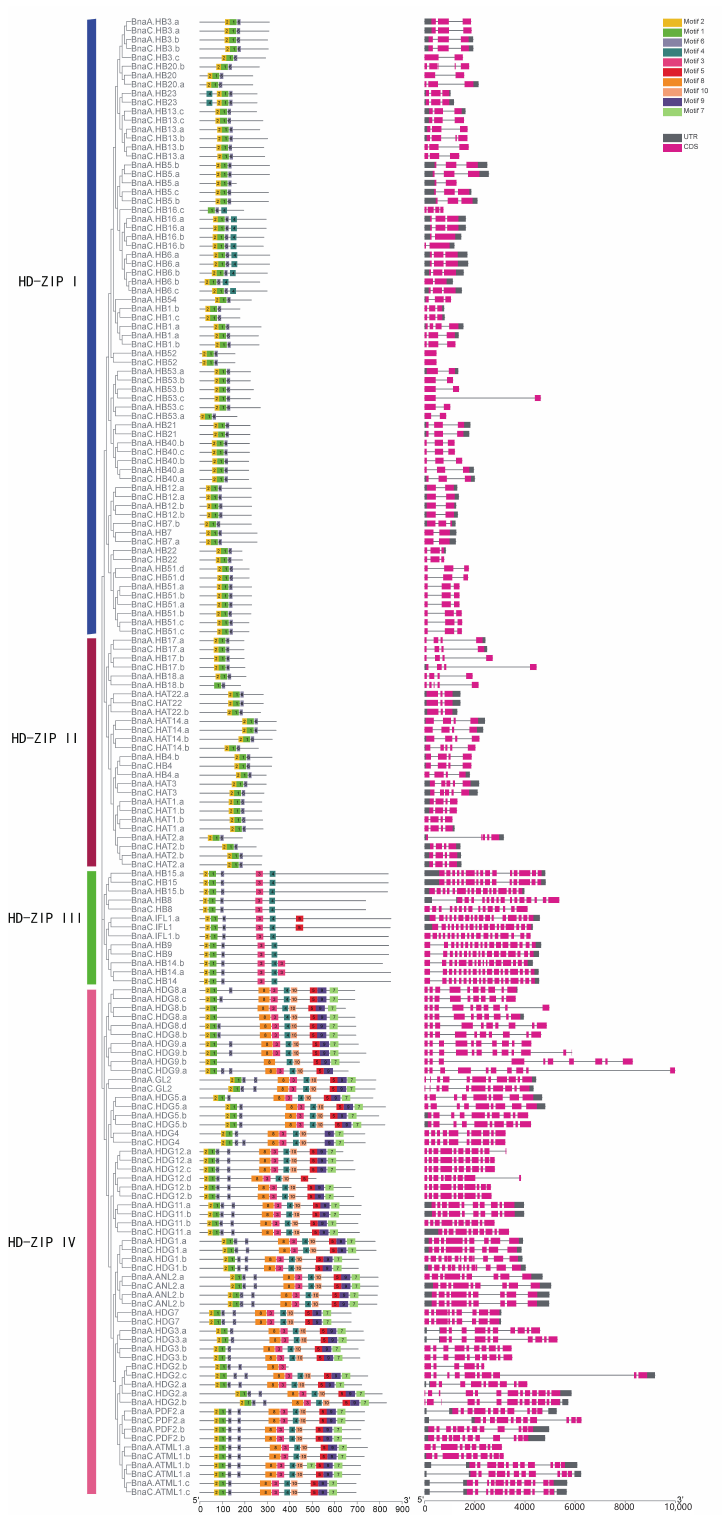
Figure 2. Phylogenetic tree ( Left ), motif distributions ( Medium ), and gene structures ( Right ) of the HD-Zip family in B. napus. The gene structures and motifs had a similar distribution in the same subfamily, and were more complex in subfamily III/IV than in subfamily